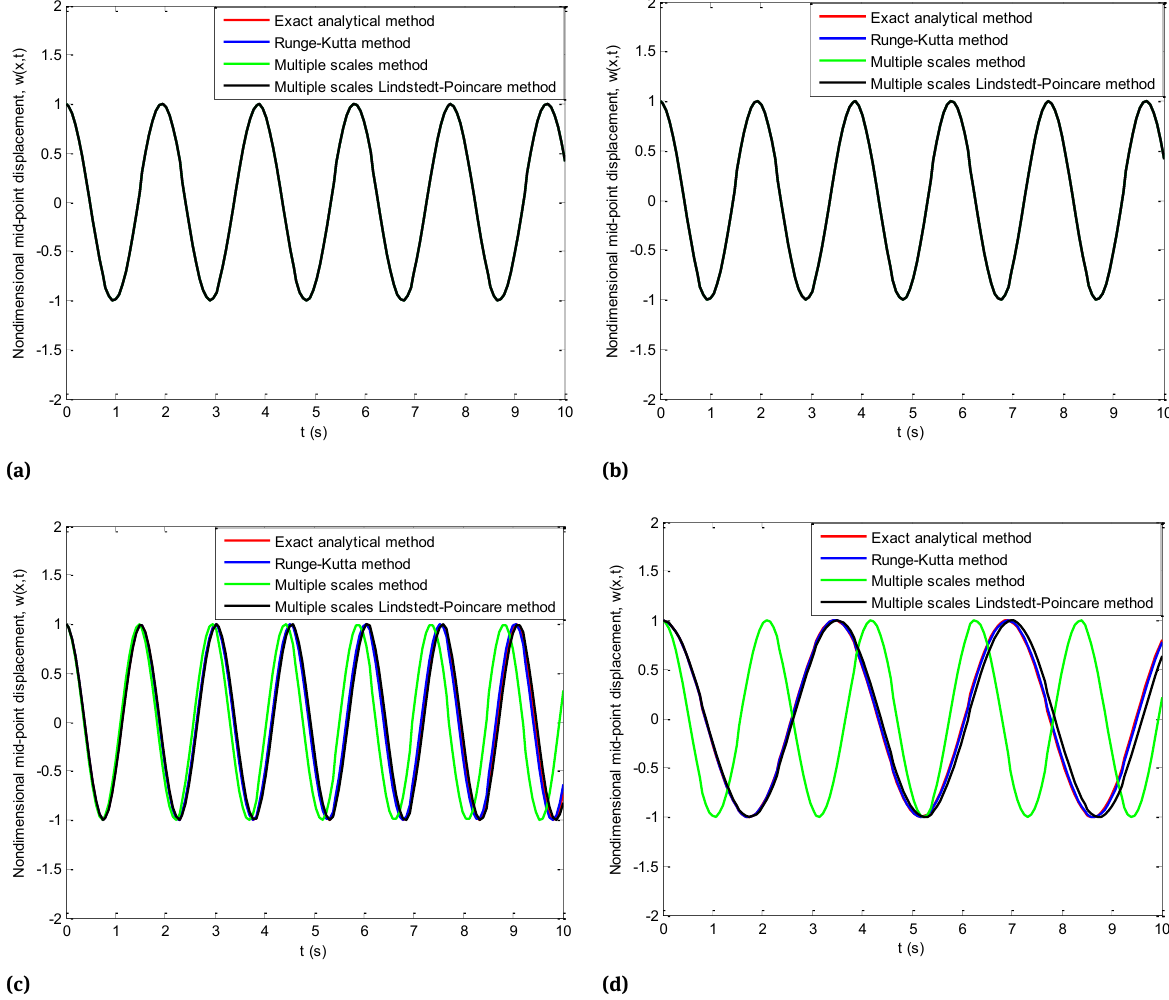
Figure 2: (a) Comparison of results when ε = 0.1 , a 0 = ˜ λ 2 = ˜ λ 3 = 1 , ω 0 = π (b) Comparison of results when ε = a 0 = ˜ λ 2 = ˜ λ 3 = 1 , ω 0 = π (c) Comparison of results when ε = a 0 = ˜ λ 2 = 1 , ˜ λ 3 = 10 , ω 0 = π (d) Comparison of results when ε = a 0 = ˜ λ 2 = 1 , ˜ λ 3 = 100 , ω 0 =